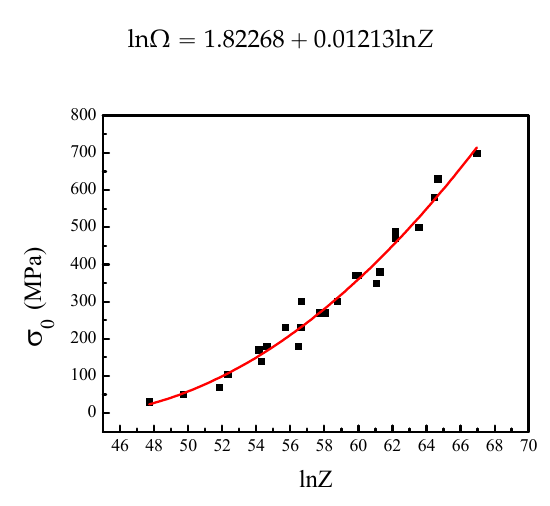
Figure 13. The plot of σ 0 ‐ ln Z .